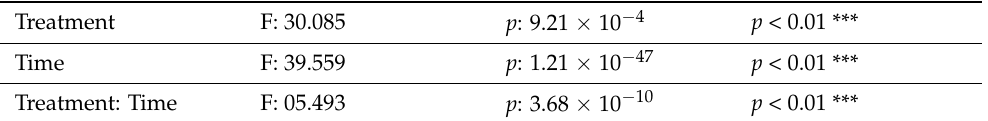
Table 2. Results of repeated measures ANOVA of C. epigejos cover. Asteriks indicate statistical significance.